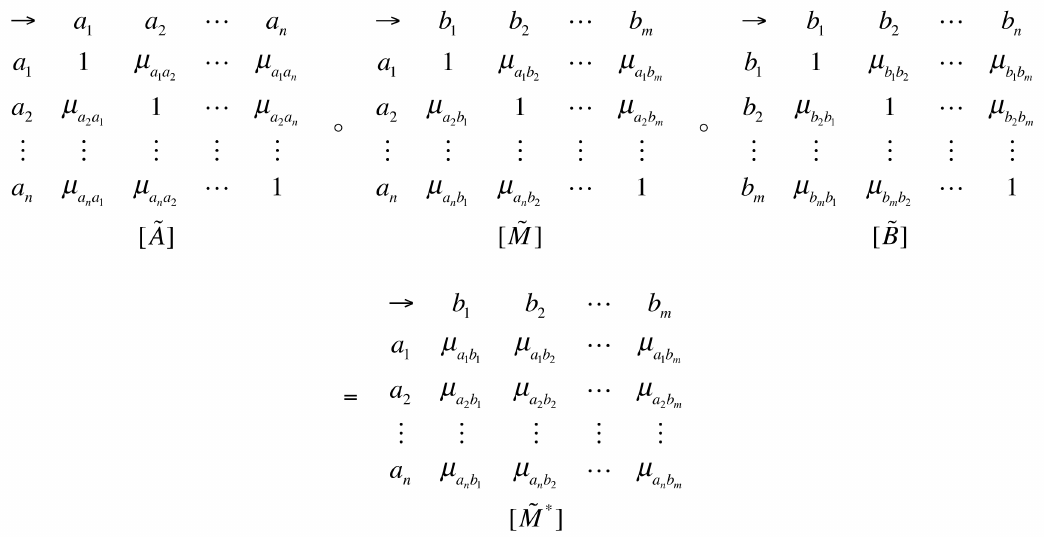
Figure 3. Incident matrix: second-generation causes and effects.